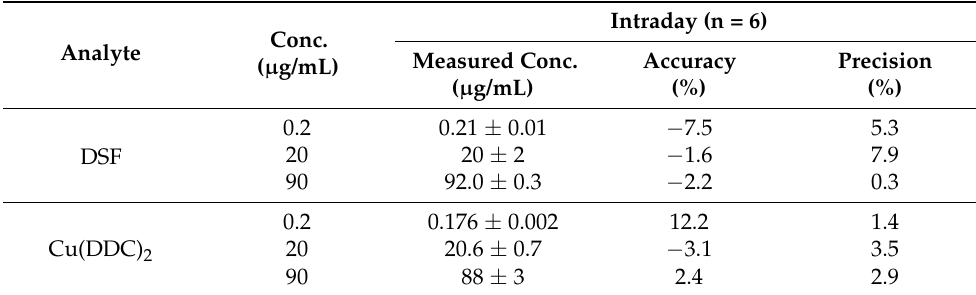
Table 9. Intraday accuracy and precision for ruggedness evaluation. Results are expressed as mean ± SD. Analyte